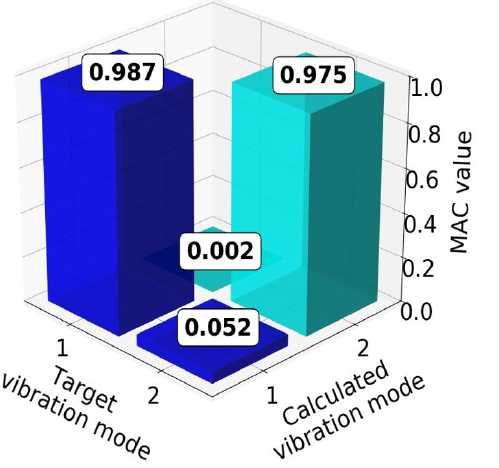
Figure 21. Modal assurance criterion for the mode shapes